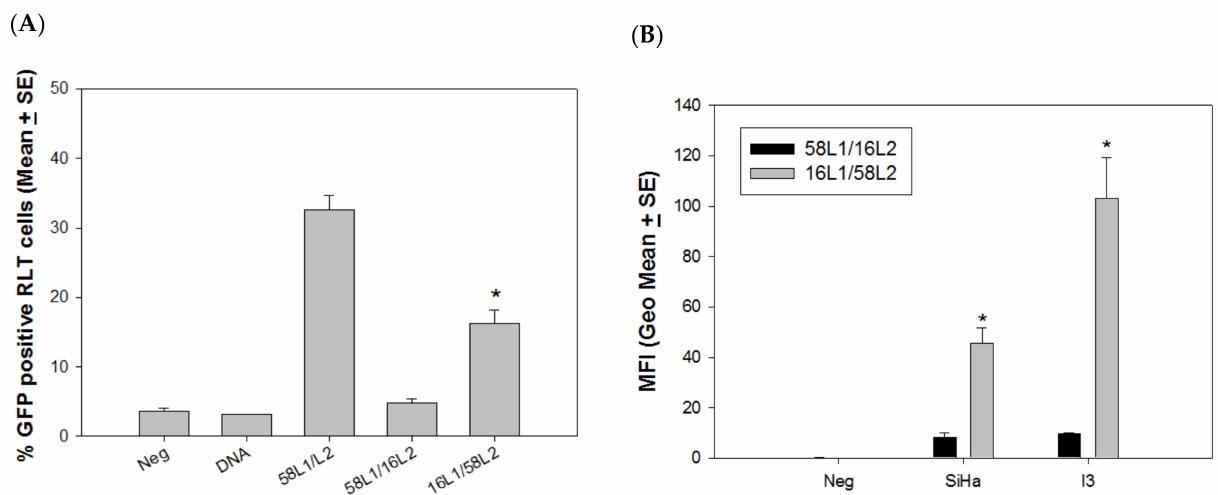
Figure 5. Delivery efficacy of external DNA is L2-dependent. Two hybrid VLPs, 16L1/58L2 and 58L1/16L2, were tested for attached DNA delivery with GFP DNA in rabbit and human cells. ( A ) The delivery efficiency of hybrid VLP-16L1/58L2 was partially restored in RLT cells when compared with VLP-58L1/16L2. Significantly more cells expressed GFP when delivered by VLP-16L1/58L2 (similar to VLP-58) when compared to VLP-58L1/16L2 (similar to VLP-16) in rabbit cells ( p < 0.05, unpaired Mann Whitney test, indicated by *). ( B ) Additionally, two more cell cultures (a rabbit cell line (I3) and a human cell line (SiHa)) were tested for hybrid VLP delivery. A similar pattern was found, as shown in RLT cells in the above experiments ( p < 0.05, unpaired Mann Whitney test, indicated by *).